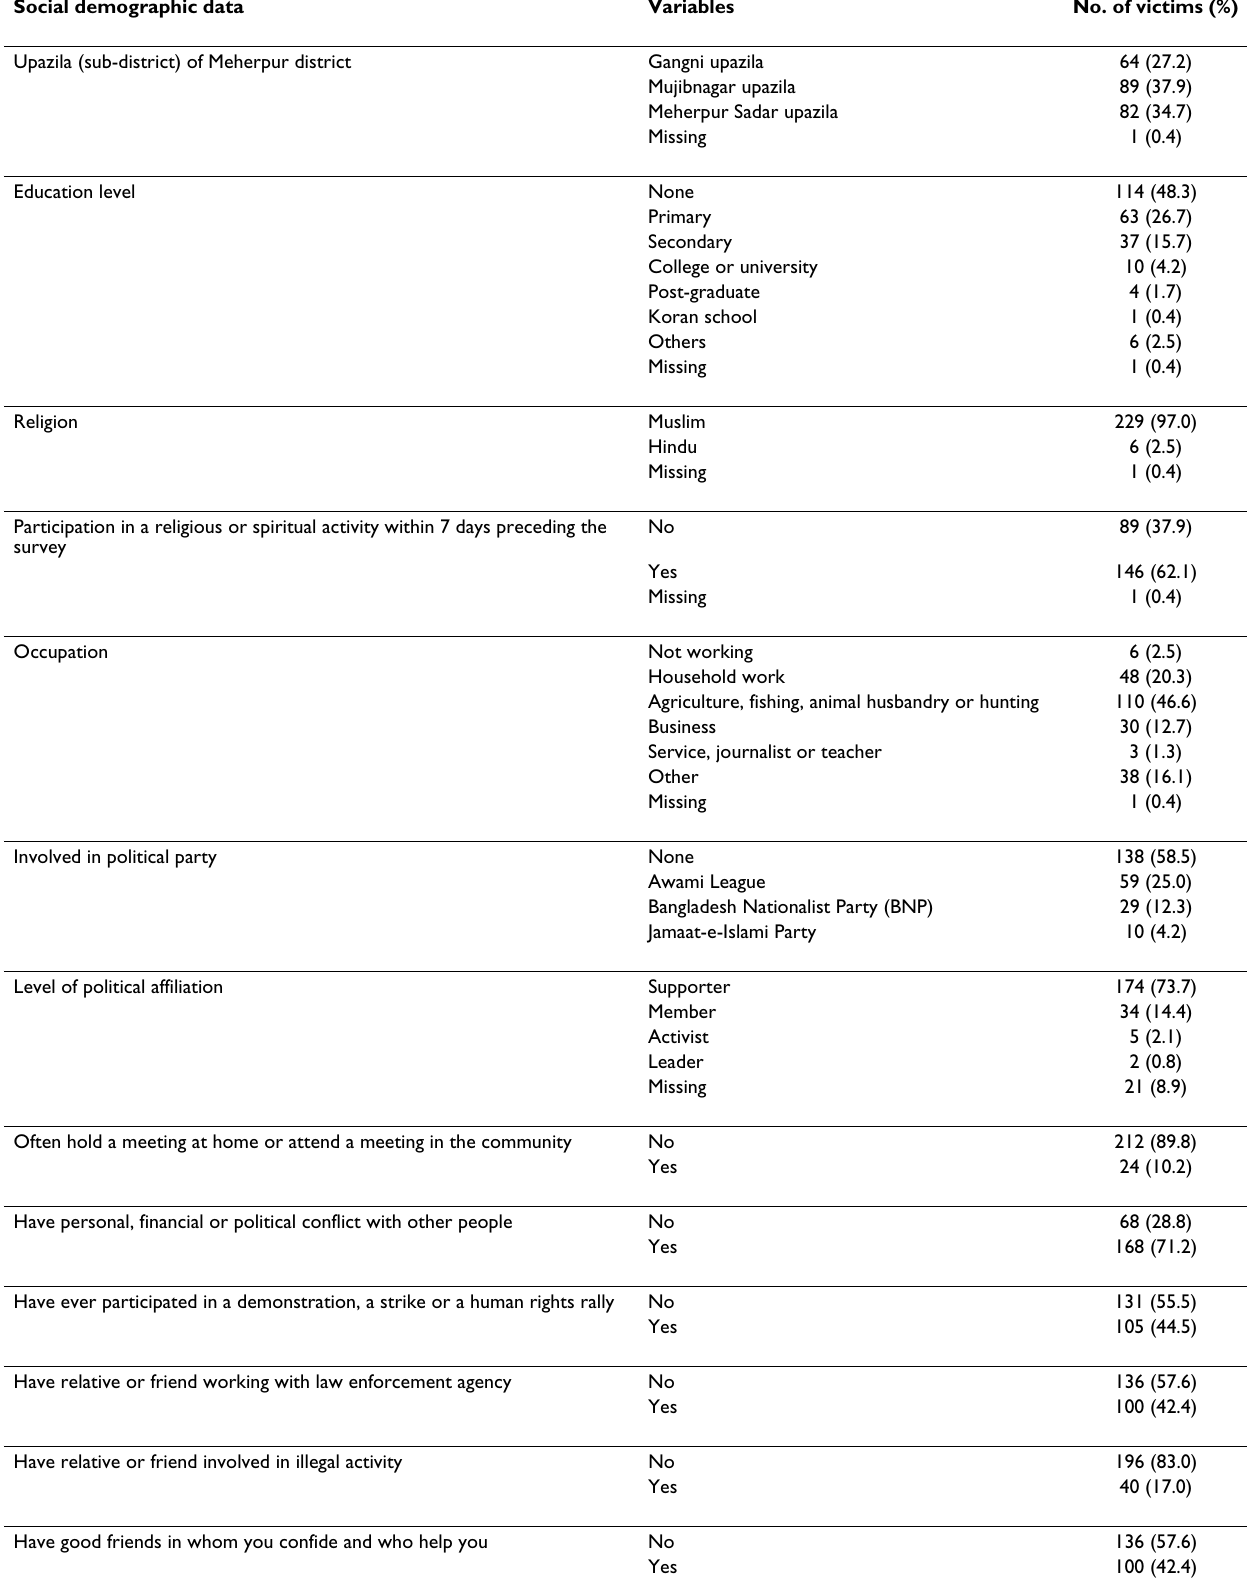
Table 1: Social demographic profile of study participants, n = 236 Social demographic data Variables No. of victims